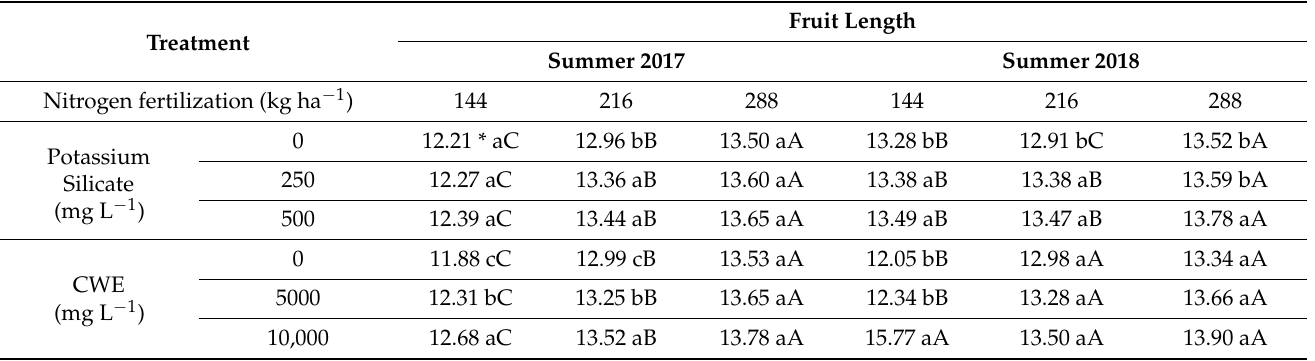
Table 5. Means of fruit length (cm) as affected by the nitrogen fertilization × potassium silicate and nitrogen fertilizer × clove water extract interaction during 2017 and 2018.